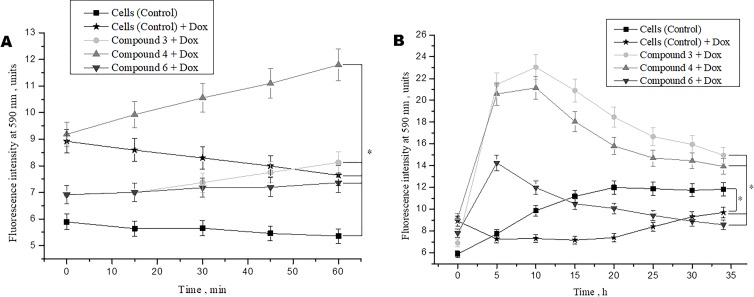
Effects of DNICs on cell viability of fibroblasts, treated with doxorubicin for 60 min (A) and 35 h (B). DNICs (2 × 10-4 M) were added to HLEF-104 cells, then doxorubicin (1.4 × 10-4 M, 20 min after DNICs treatment) was added, cell viability was tested in fibroblasts by AlamarBlue® Cell Viability Assay after doxorubicin-induced toxicity. *P ≤ 0.05 vs. control group. The values presented are the means ± SD of four independent experiments, n = 4.